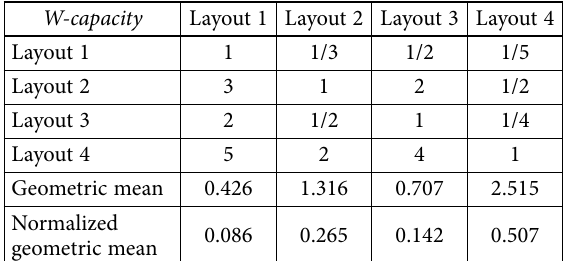
Table 6. The comparison matrix of the layouts for warehousing capacity (W-capacity)